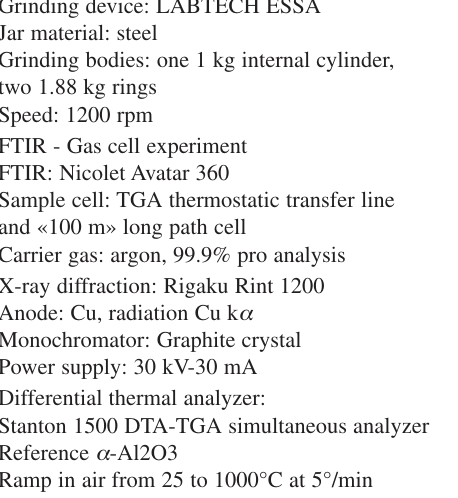
Table I. Experimental conditions. Grinding device: LABTECH ESSA Jar material: